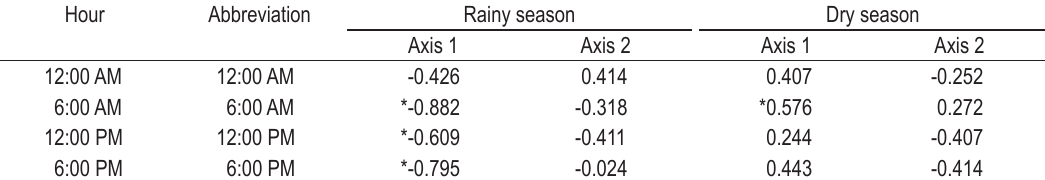
Table 5. Correlations between abundance of Odonata and sampling hours during the rainy and dry seasons and the first two CCA axes.